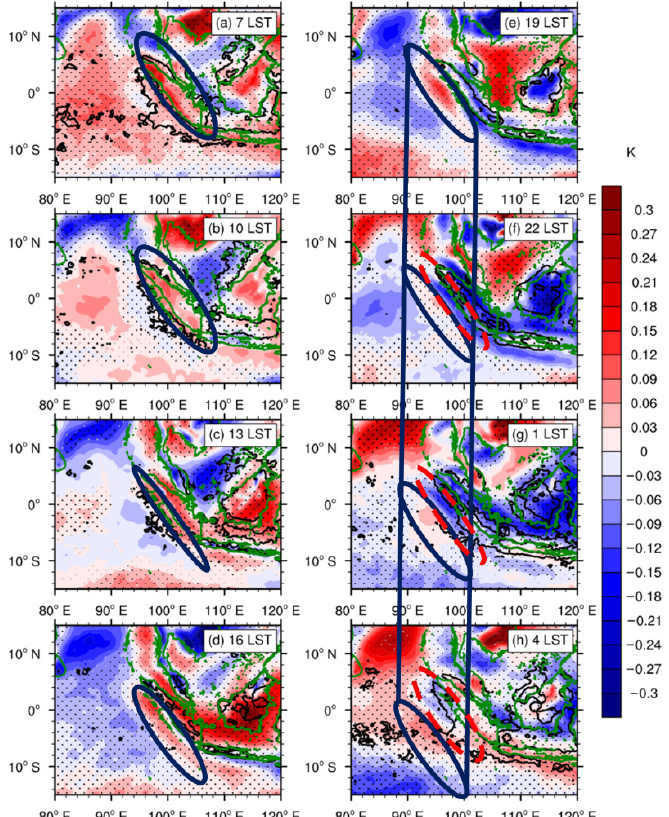
Figure 10. The diurnal variation of 700-hPa temporal temperature disturbance (K) with spatial mean subtracted (shaded) as well as precipitation rate (contour, interval 0.5 mm h − 1 ), as averaged at ( a ) 07 LST, ( b ) 10 LST, ( c ) 13 LST, ( d ) 16 LST, ( e ) 19 LST, ( f ) 22 LST, ( g ) 01 LST, and ( h ) 04 LST, in DJF 2011–2020. The local standard time (LST) is calculated with a Coordinated Universal Time (UTC) offset of +7. The solid (dashed) ellipses mark the positive (negative) signals. The grey and black dots indicate the 90% and 95% confidence according to the Student’s t-test.